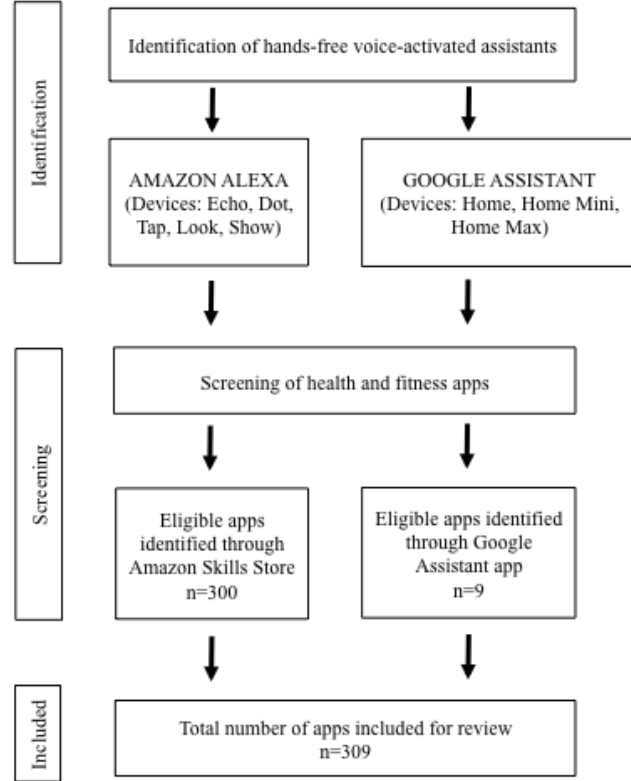
Figure 1. Health app identification, screening, and review assessment